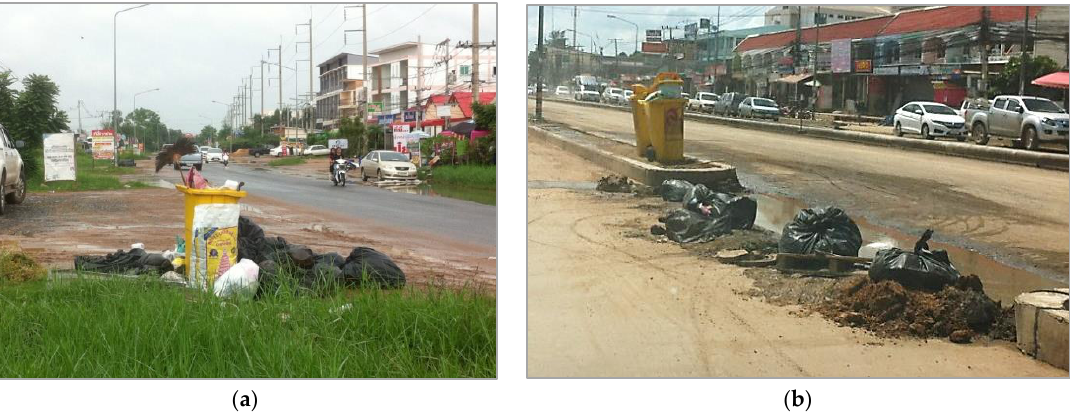
Figure 3. Typical scene of road-side waste in Tha Khon Yang. ( a ) Urbanized zone 1 (Observed 2/09/2015); ( b ) Urbanized 2 (Observed 25/07/2016).